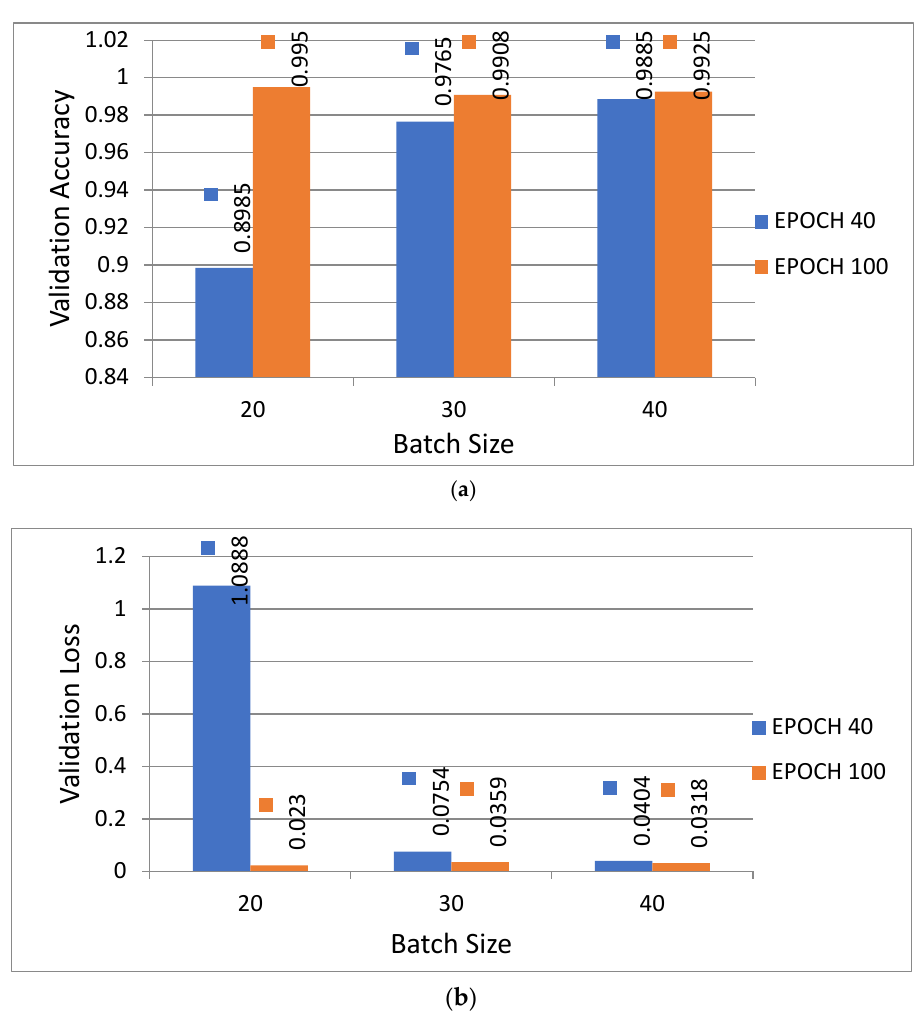
Figure 12. Performance of proposed model at 100 and 40 epochs with batch sizes of 20, 30 and 40: ( a ) validation accuracy graph; ( b ) validation loss graph.